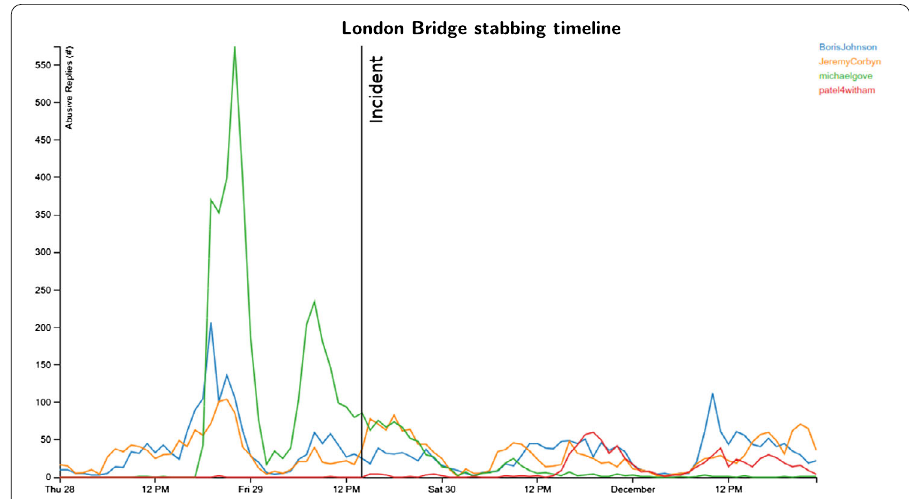
Figure 6 London Bridge stabbing timeline. Per-hour timeline for the most abused individuals around the London Bridge stabbing. The time of the incident is highlighted using a vertical line. The large peak prior to the stabbing relates to the climate